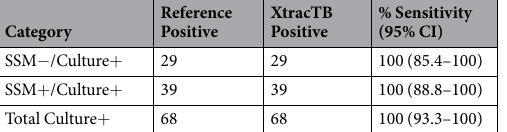
Table 2. Tuberculosis detection by XtracTB Assay of FIND culture positive specimen panel (N = 70). SSM − = concentrated sputum smear microscopy negative; SSM + = concentrated sputum smear microscopy positive. 95% CI = 95% confidence interval. 3% of the specimens had invalid